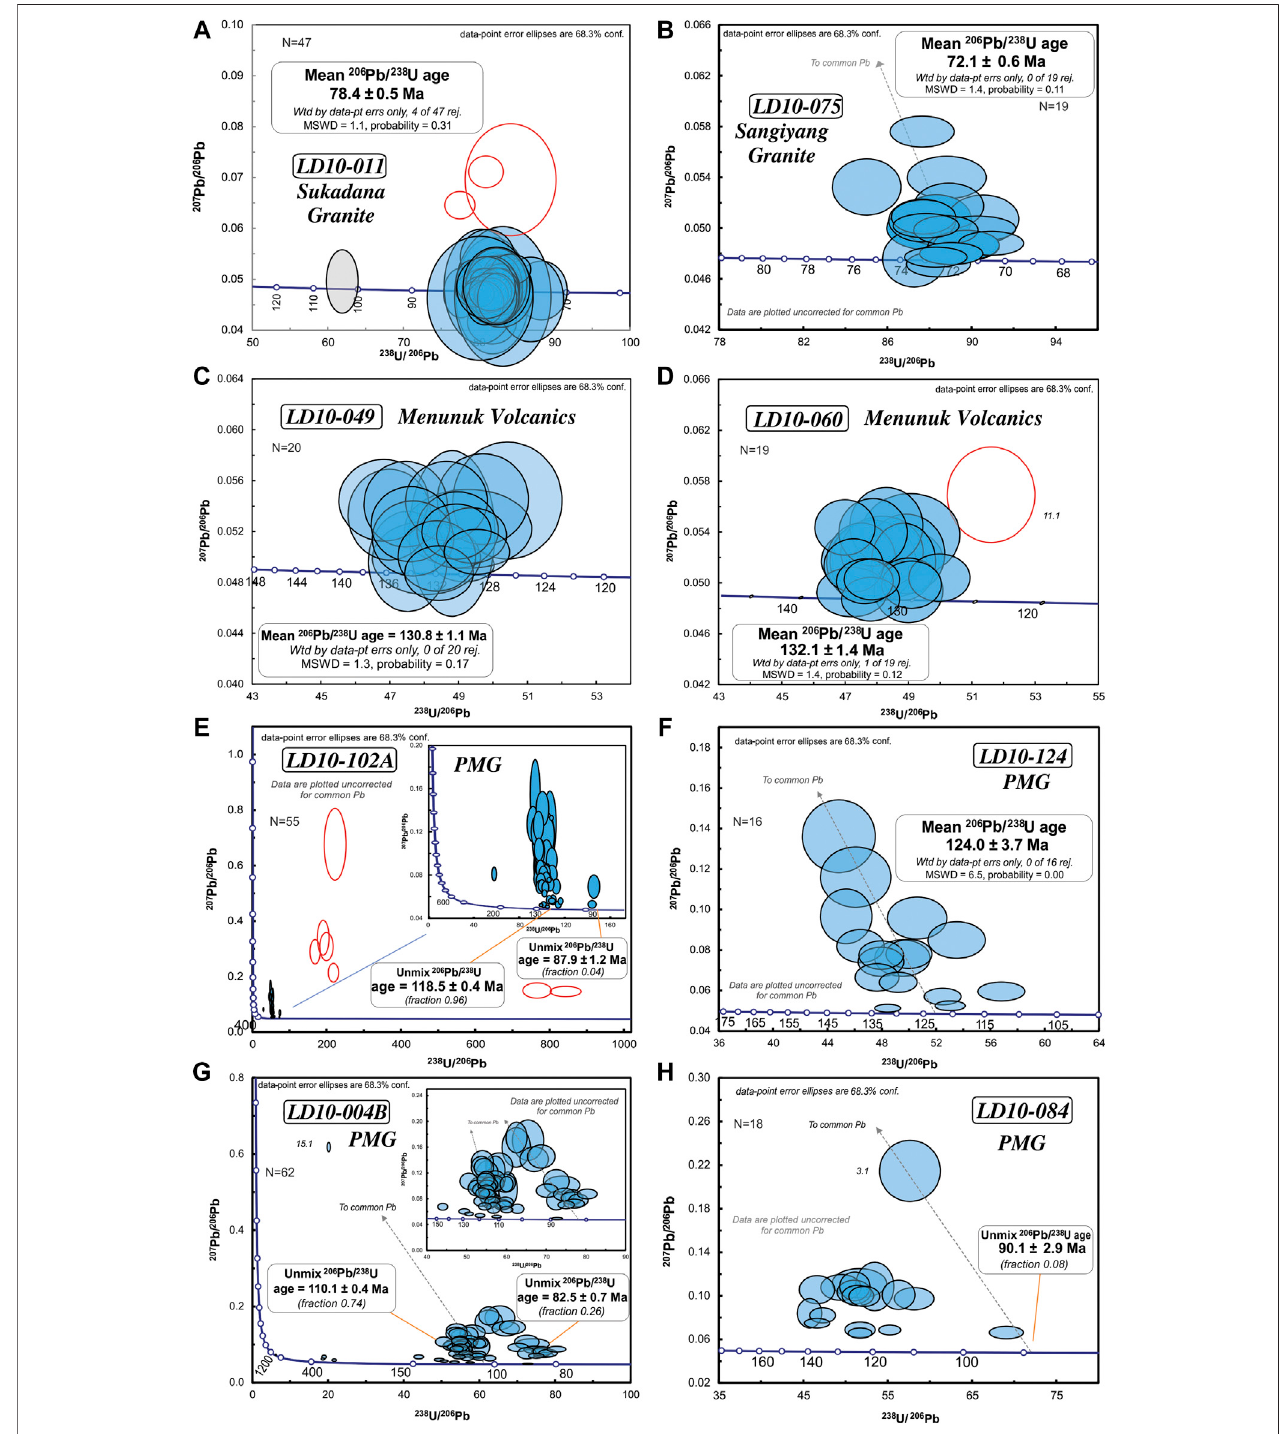
FIGURE6| ZirconU-PbweightedmeanagecalculationandTera-Wasserburgdiagramsforpost-subductionplutonsintheSSZ: (A) SukadanaGraniteLD10-011, (B) SangiyangGraniteLD10-075, (C, D) Menunuk Volcanicsfrom the NSZ, and (E – H) metamorphicrocks from thePinoh Metamorphic Groupwith (E) LD10-102 A, (F) LD10-124, (G) LD10-004B, (H) LD10-084. SHRIMP diagrams display ages uncorrected for common Pb and for LA-ICP-MS results common Pb corrected ages are displayed. Common Pb correction after Anderson (2002). Age cluster calculation for PMG rocks with the unmix function of Isoplot.